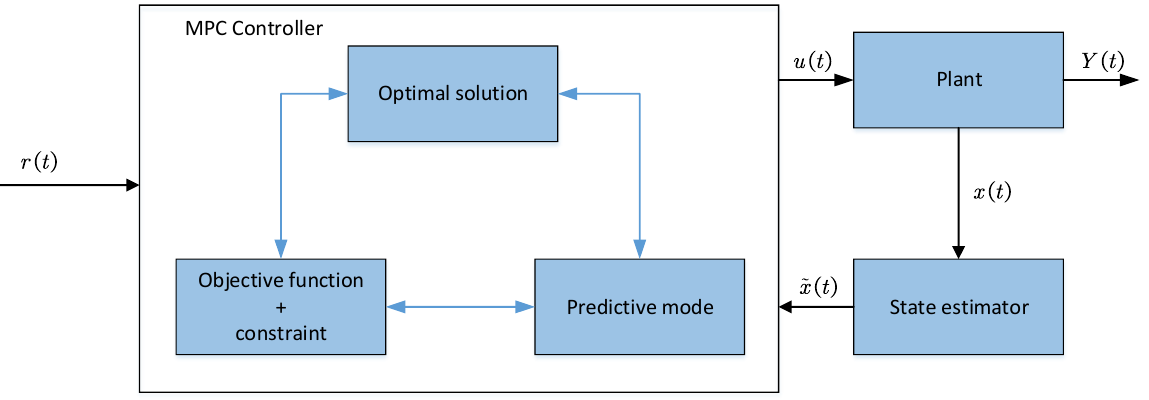
Figure 4. Principle of the model predictive control.